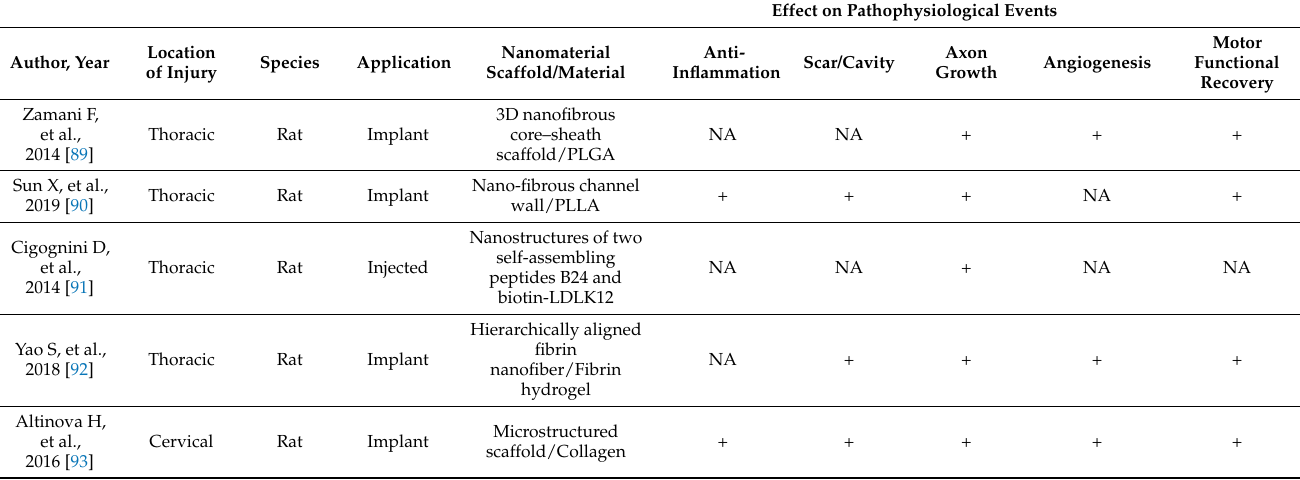
Table 3. Summary of the included studies and the effect of nano-/micro-scale biomaterial scaffolds application in